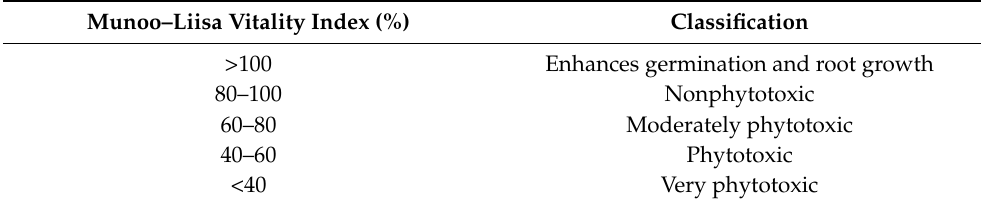
Table 1. Phytotoxicity classification (adapted from